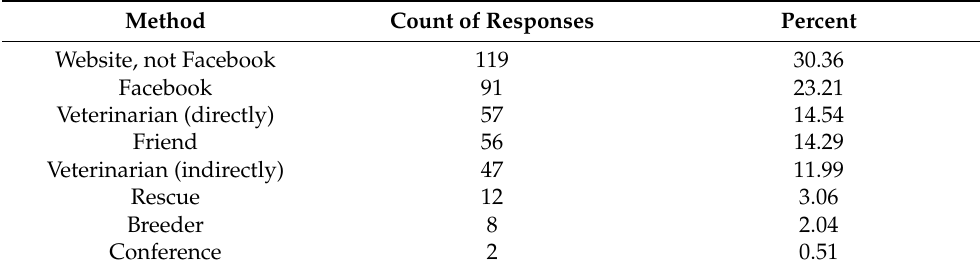
Table 3. How cat owners first learned about the existence of GS-441524 therapy for FIP. Owners were able to list more than one source, so the total number of responses is higher than the total number of